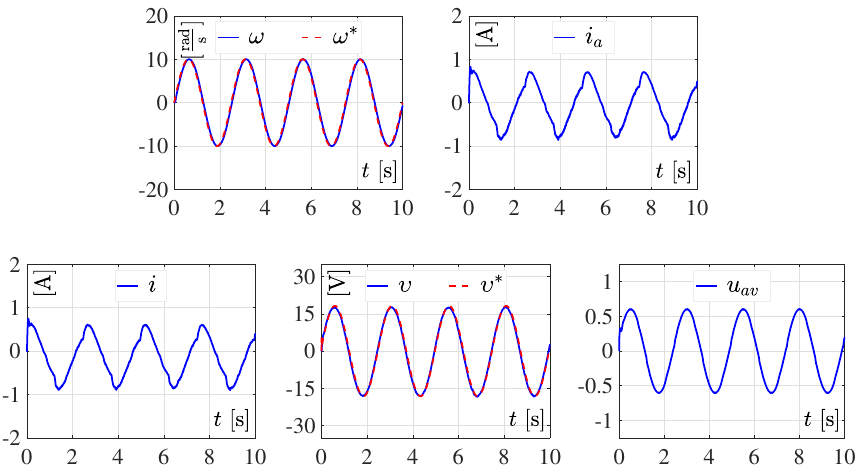
Figure 7. Experimental results when the second desired angular velocity profile, given by (23), is contemplated for the system in closed-loop.